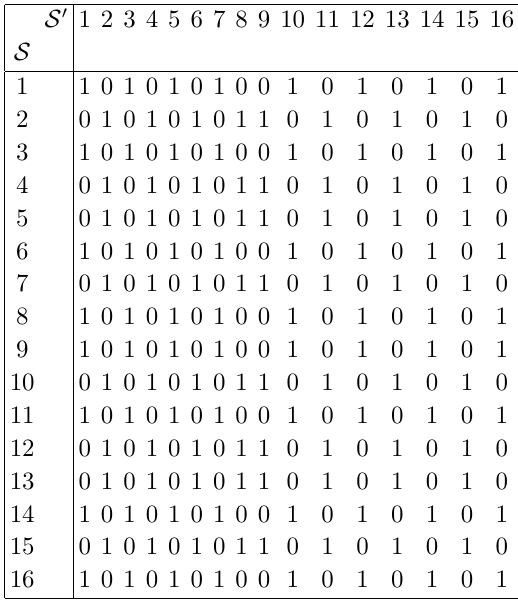
Table 33 . Gadget values for P